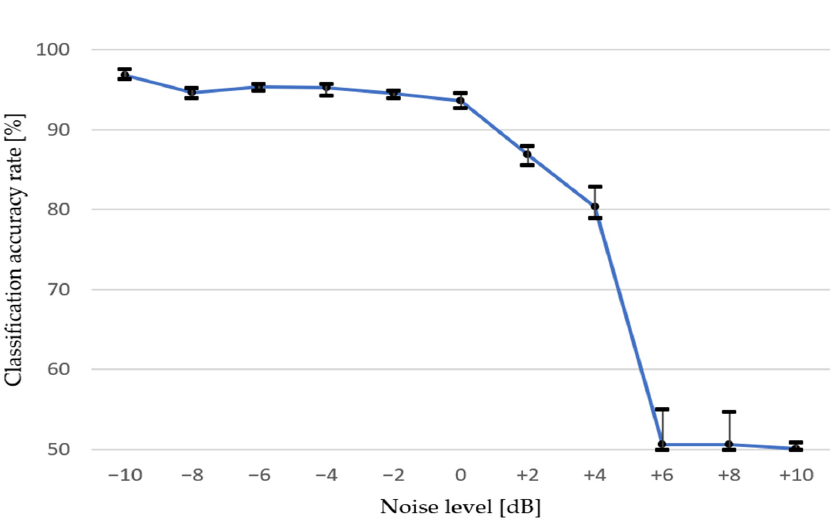
Figure 11. Trend of classification accuracy across all tested intensities of EN for data represented by spectrogram 2.